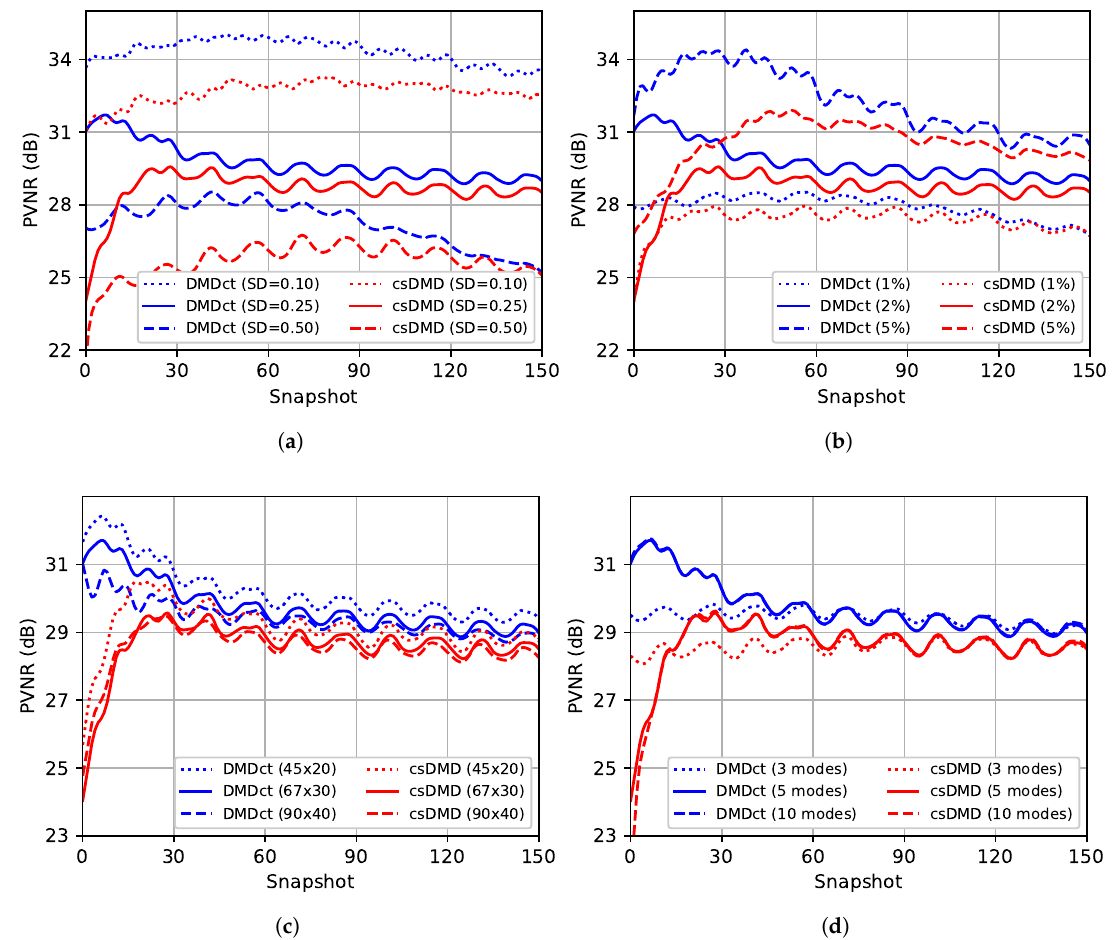
Figure 8. Investigating the effect of changing various parameters on per-snapshot PVNR values of DMDct and csDMD reconstructions of u velocity component of the wake behind a cylinder at Reynolds number Re = 100. Blue and red, respectively, represent DMDct and csDMD. The solid lines correspond to the nominal values. ( a ) The effect of variation of noise standard deviation. ( b ) The effect of variation of sampling ratio. ( c ) The effect of changing the number of basis vectors. ( d ) The effect changing the number of dynamic modes. The lines corresponding to 10 dynamic modes are overlapped by the lines corresponding to 5 modes most of the